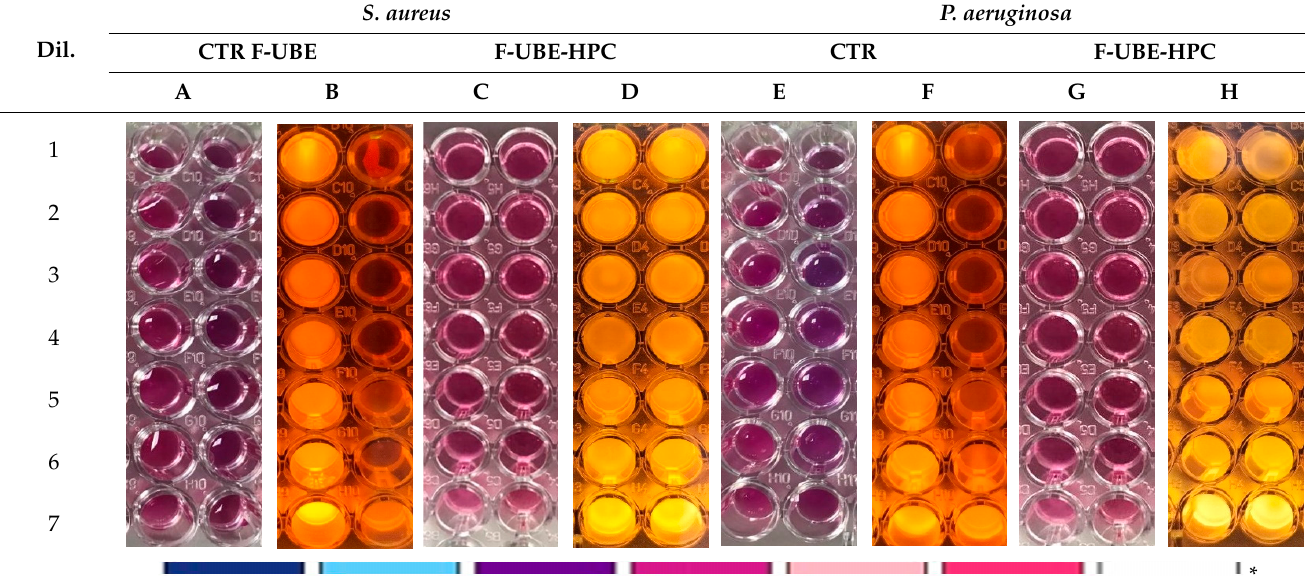
Table 5. Inhibitory activity of F-UBE-HPC on S. aureus and P. aeruginosa. Dil.